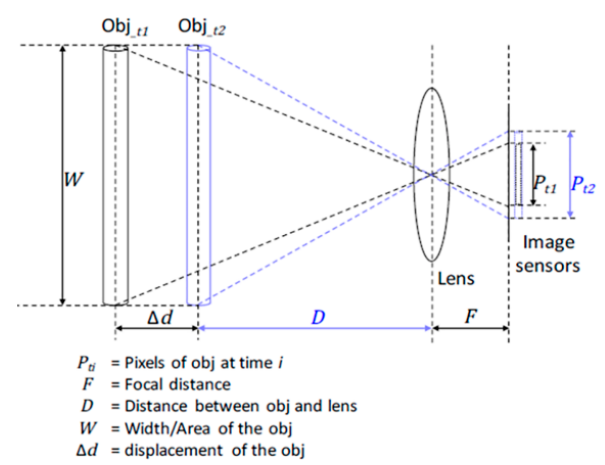
Figure 9. Triangular similarity using a single camera [69].